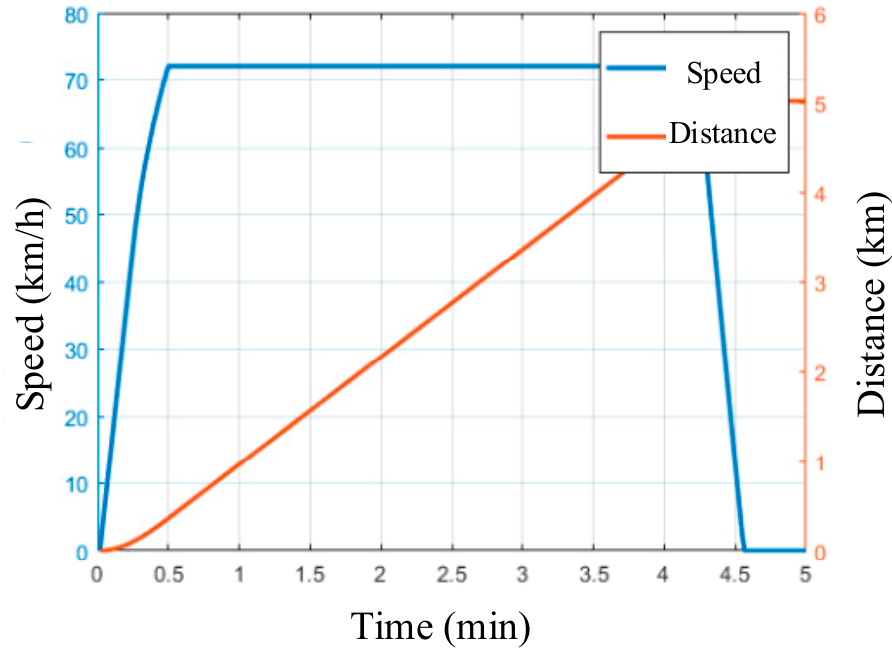
Figure 8. Relationship between train operation position and speed.